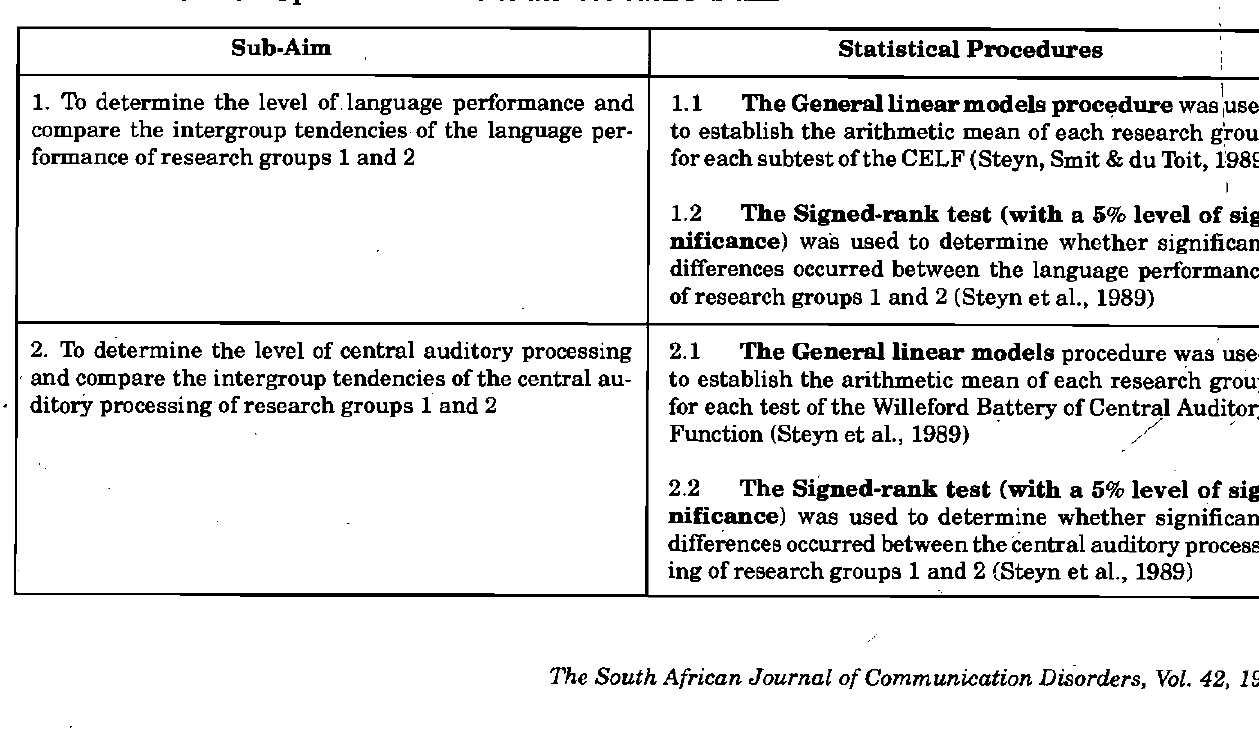
Table 2: The statistical procedures used to achieve each sub-aim